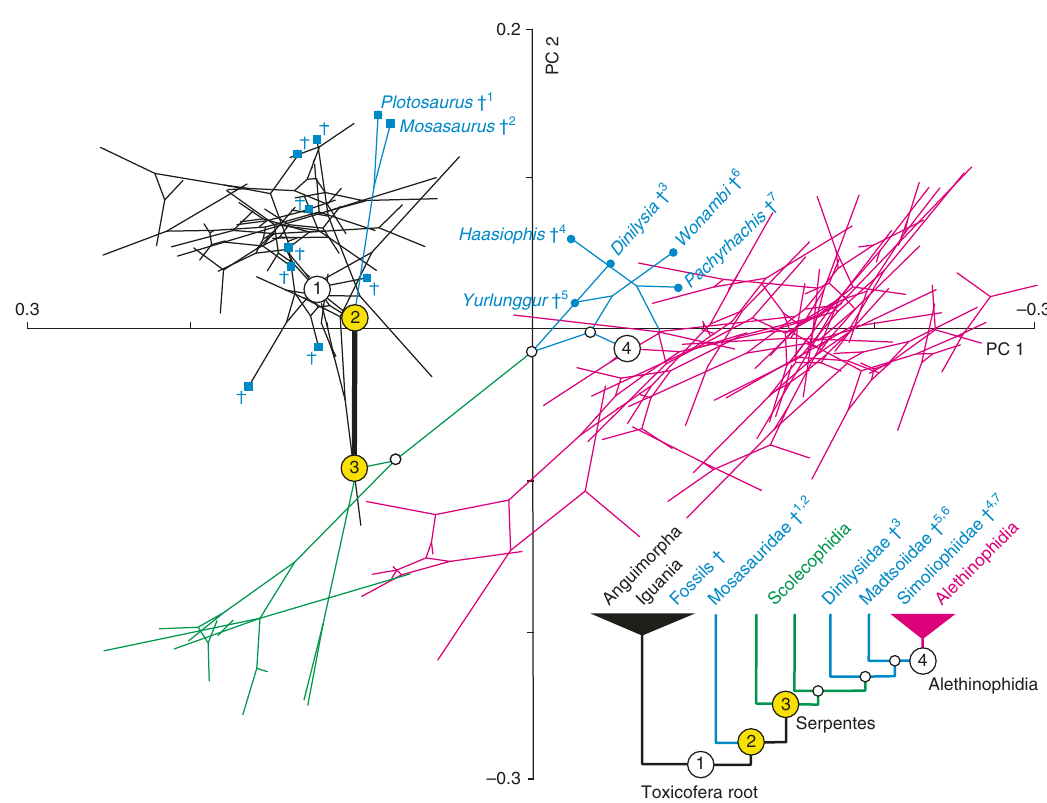
Fig. 3 Origin and diversi fi cation of skull morphology in snakes. Phylomorphospace created by projecting the squamate phylogeny presented in Fig. 1 onto the morphospace delimited by the fi rst two PC axes. For clarity, only Toxicofera specimens are shown. Ancestral character estimation for each internal node was performed using squared-change parsimony, and branch lengths were derived from estimated divergence times. The position of lizard and snake fossils (with species names indicated for specimens already proposed to be at the origin of snakes) is shown by blue squares and blue dots, respectively, and key ancestral nodes are numbered and colored as in Fig. 1. The estimated lizard-to-snake transition took place between nodes 2 and 3 (yellow nodes), as indicated by the thick bold line. The bottom right cladogram represents a simpli fi ed phylogenetic tree of the major Toxicofera lineages (including fossil families, with colors as in Fig. 1) and the ancestral nodes shown in the